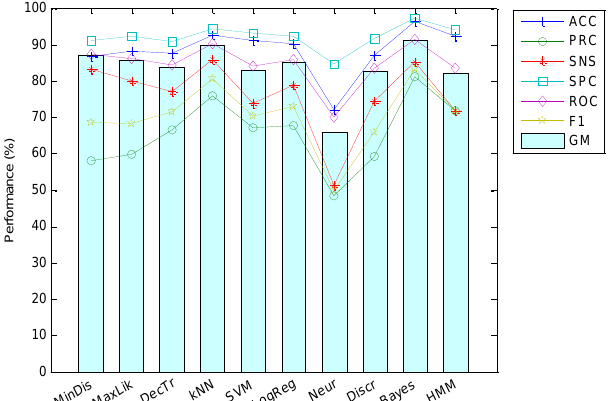
Figure 29. Classification performance using MFCCs (optimal values in every option).